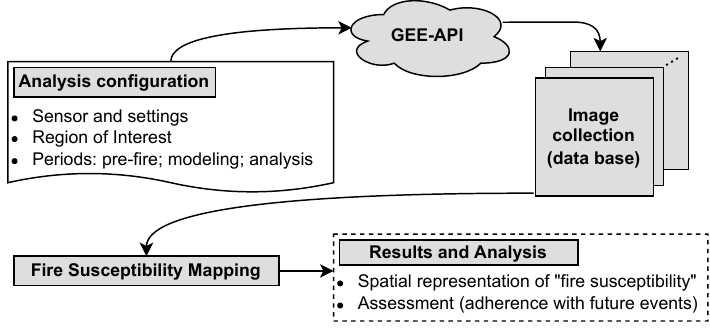
Figure 1. Overview of the proposed methodology.